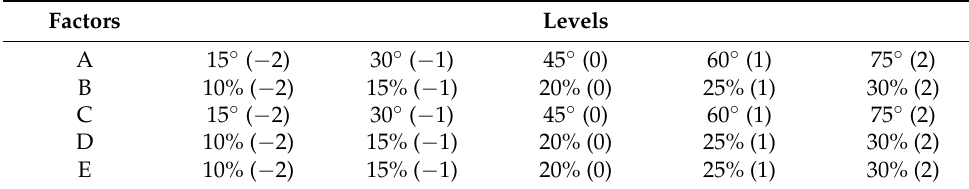
Table 3. Factors and levels of RSM test.